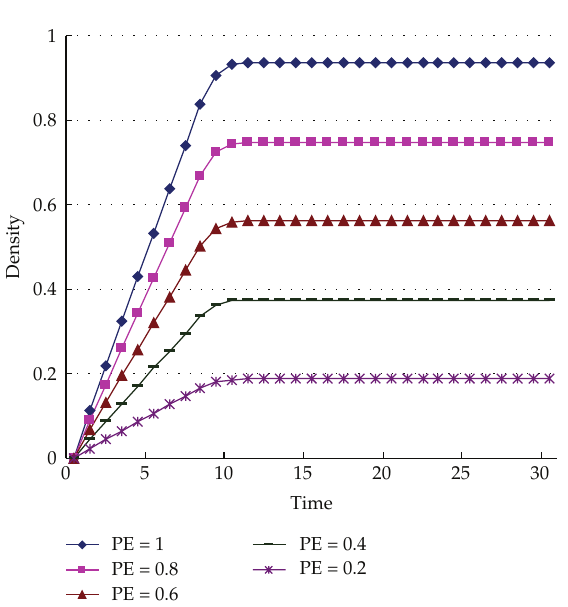
Figure 6: Average density with di ff erent entering flow intensity, where r 1 (cid:10) 0 . 6, r 2 (cid:10) 0 . 2, r 3 (cid:10) 0 . 0, and r (cid:10) 0 . 4